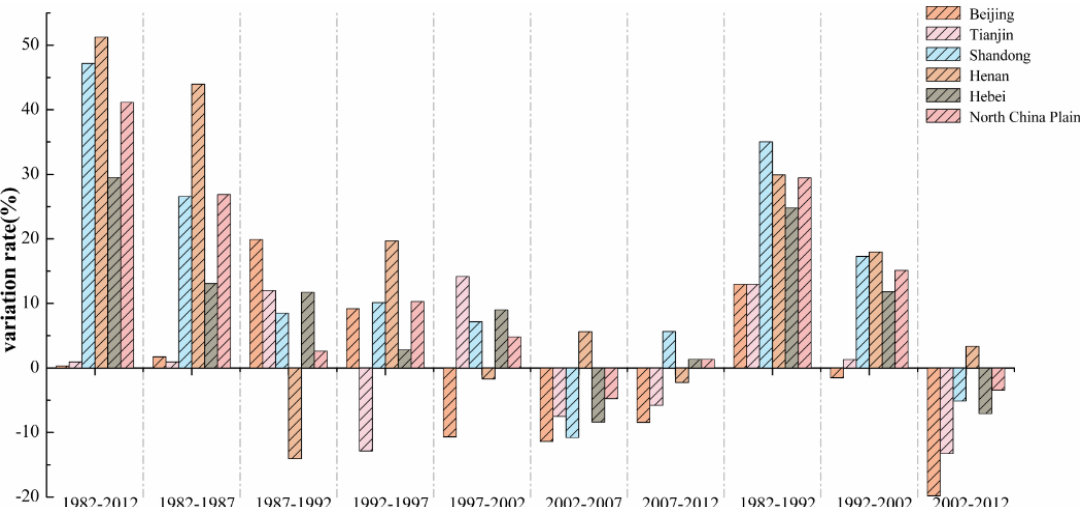
Figure 11. A comparison of the rate of interannual variability in the Multiple Cropping Indices of dry land in the North China Plain between the different cities/provinces for nearly 30 years.